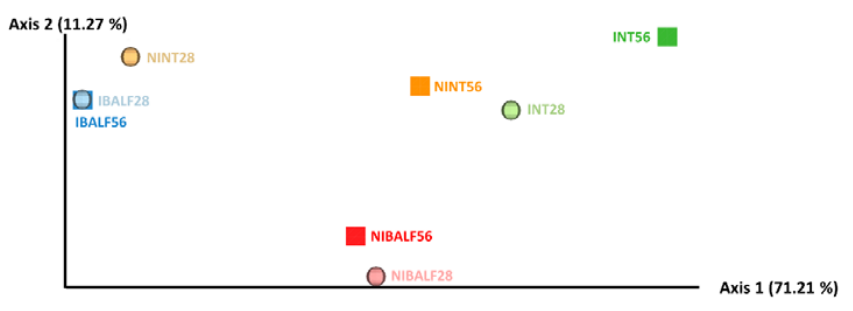
Figure 2. Weighted unifrac distance diagrams with pooled nasal turbinate (NT) and pooled bronchus-alveolar lavage fluid (BALF) samples of infected and non-infected animals at 28 and 56 days post-inoculation (dpi). NINT28 = non-infected NT 28 dpi; NINT56 = non-infected NT 56 dpi; NIBALF28 = non-infected BALF 28 dpi; NIBALF56 = non-infected BALF 56 dpi; INT28 = infected NT 28 dpi; INT56 = infected NT 56 dpi; IBALF28 = infected BALF 28 dpi; IBALF56 = infected BALF 56 dpi.